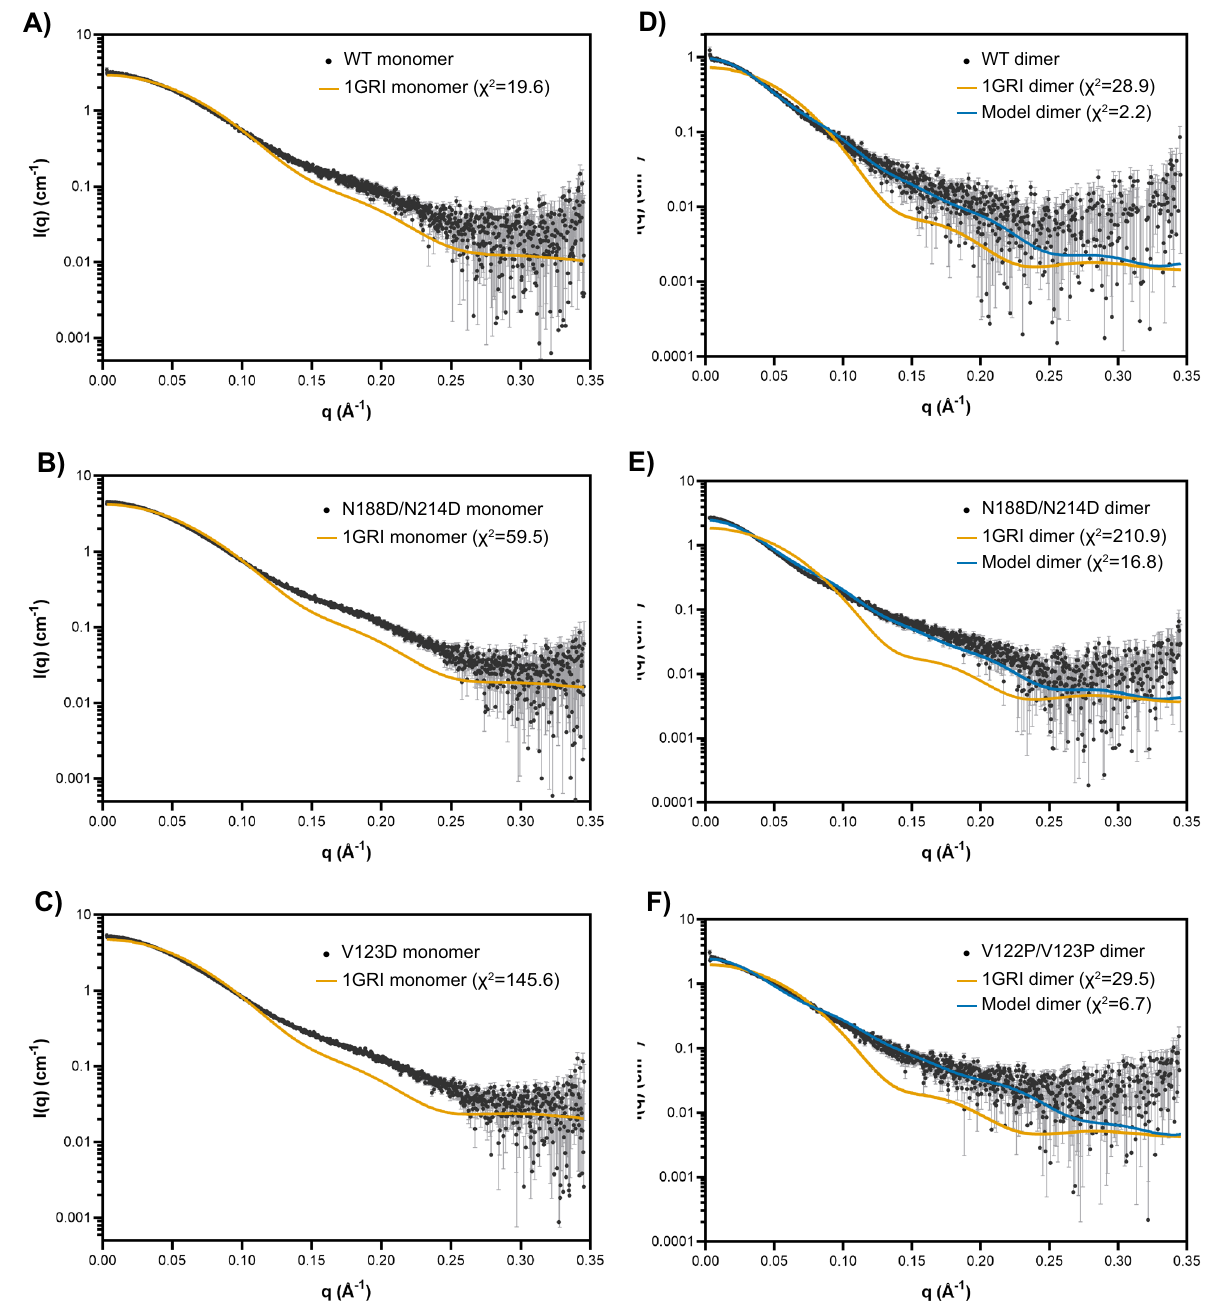
Figure 4. CRYSOL fitting of crystal structure (PDB: 1GRI) to experimental SAXS scattering profiles. SAXS profiles of the purified monomer and dimer from GRB2 WT and mutants are superimposed with theoretical profiles generated by CRYSOL of either monomer or dimer (orange) from the crystal structure (PDB: 1GRI) or the proposed SH2/SH2-mediated domain-swapped dimer model (blue). ( A ) WT monomer versus 1GRI monomer; ( B ) N188D/N214D monomer versus 1GRI monomer; ( C ) V123D putative monomer versus 1GRI monomer; ( D ) WT dimer versus 1GRI (SH2/C-SH3) domain-swapped dimer or SH2/SH2 domain-swapped dimer; (E) N188D/N214D dimer versus 1GRI dimer or SH2/SH2 domain-swapped dimer; and ( F ) V122P/ V123P putative dimer versus 1GRI dimer or SH2/SH2 domain-swapped